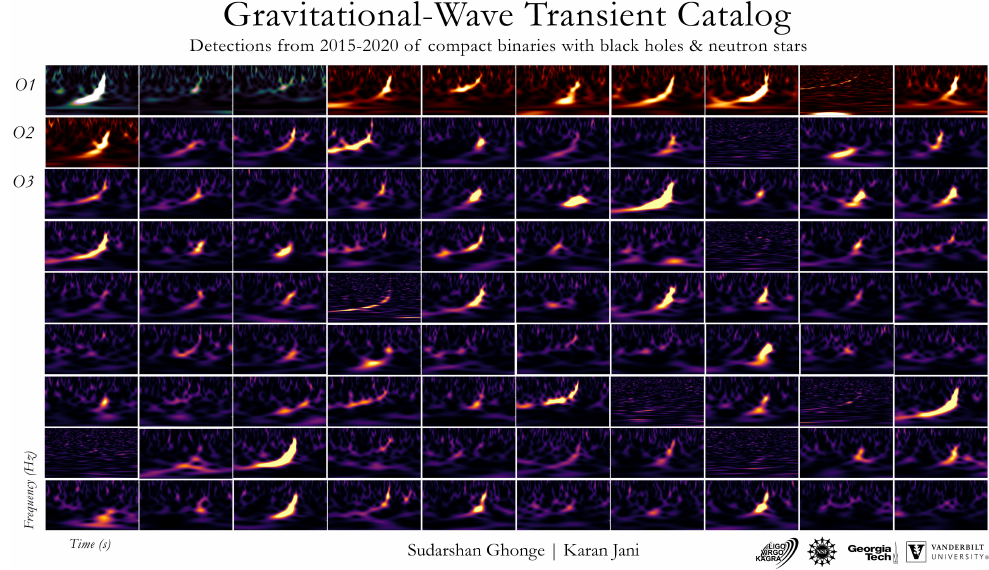
Figure 3. Collection of time-frequency maps of all the LIGO and Virgo detections in the first three observation runs. Graphics reproduced from